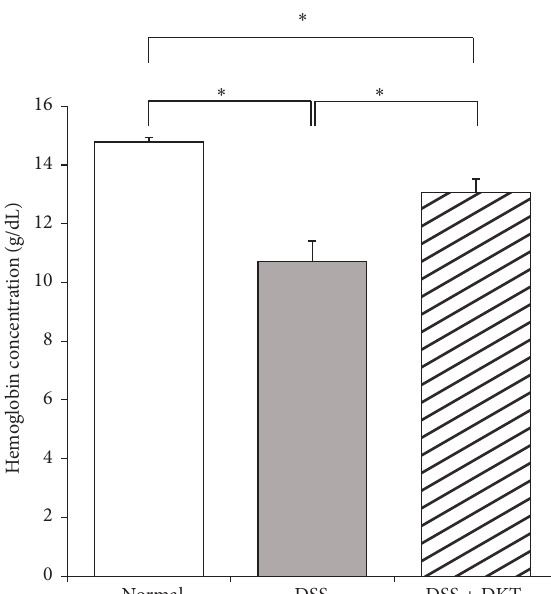
Figure3:Hemoglobinconcentrationofeachstudygroup.Normalgroup,untreatedmice.Dextransulfatesodium(DSS)group,miceprovided with 5% DSS for 7 days. DSS + daikenchuto (DKT) group, mice provided with DKT in addition to DSS. 𝑛 = 10 mice (for normal, DSS, and DSS + DKT groups). ∗ 𝑝 < 0.05 .